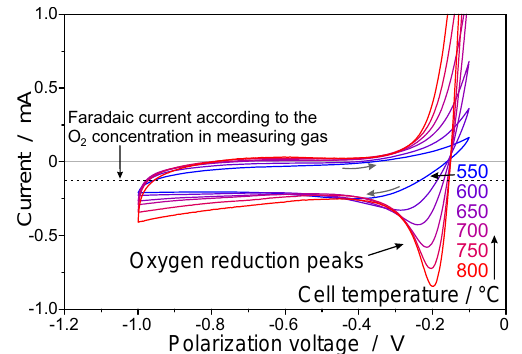
Figure 5. Voltammograms at variable potential scan rates; the base- lines (represented by dashed + coloured lines) are the exponentially increasing currents resulting from the increasing oxygen pump cur- rents at increasing polarization voltages; the lengths of the arrows represent the heights of the H 2 oxidation peaks. Inset: peak heights of the H 2 oxidation peaks in relation to the square root of the po- tential scan rate; electrode size: 7.5cm 2 ; cell temperature: 800 ◦ C; measuring gas: 100vol.ppm H 2 + 17vol.ppm O 2 in N 2 ; gas flow rate: 10sccm; open-circuit potential: − 971 . 1mV; the second cycle is